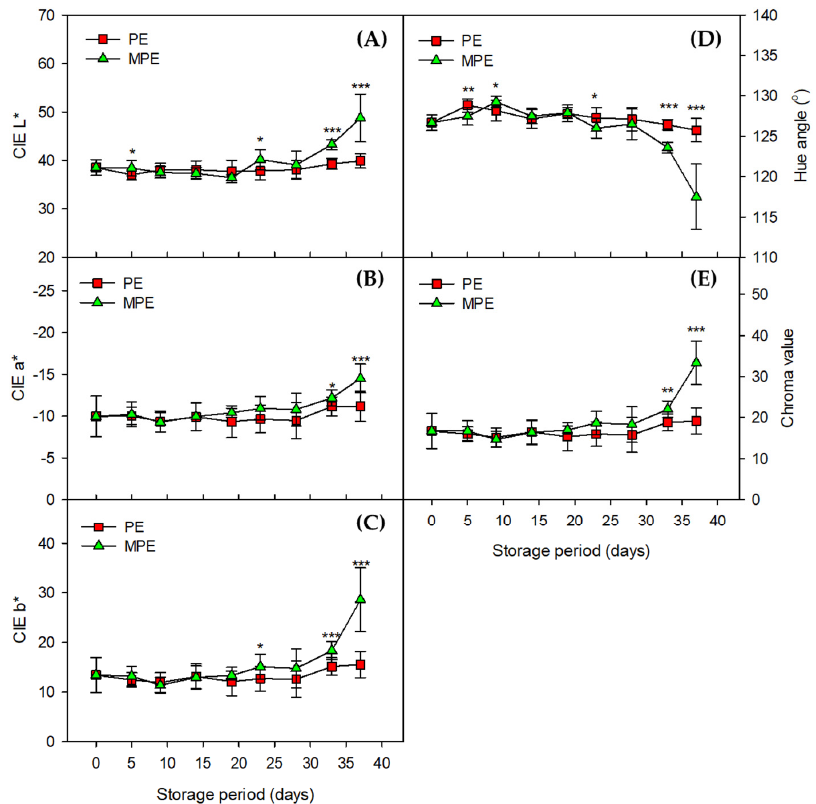
Figure 3. Changes in color values of G. littoralis during storage at 4 °C. ( A ), CIE L* value; ( B ), CIE a* value; ( C ), CIE b* value; ( D ), hue angle; and ( E ), chroma value. MAP treatment was classified into micro-perforated PE (MPE, 32 pinholes) and PE on the basis of the presence or absence of pinholes, respectively. Values are shown as mean ± standard deviation. Statistical significance was shown by a t -test between PE and MPE at each time point during storage (*** p < 0.001, ** p < 0.01, and * p < 0.05).